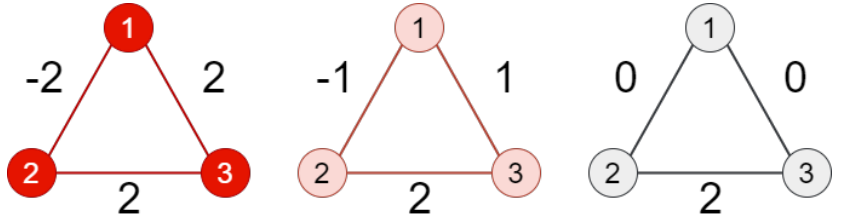
Figure 2. An example of re-balancing in a signed triangle.